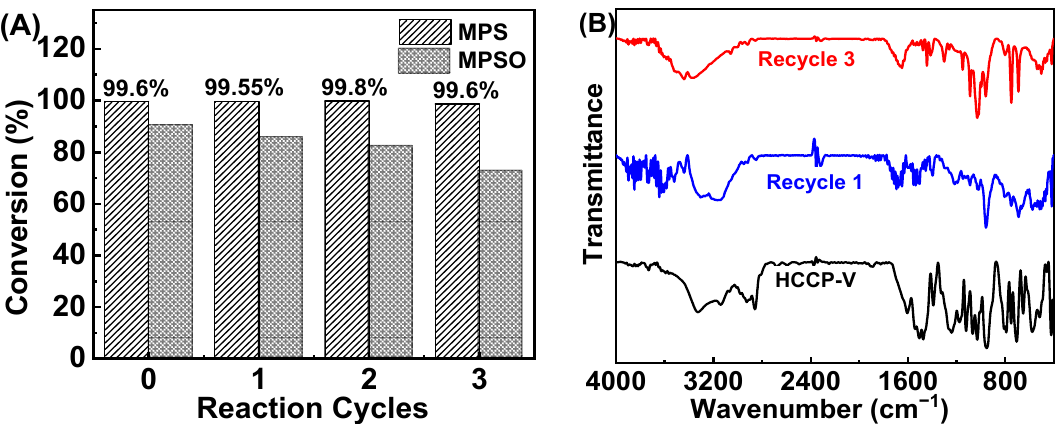
Figure 8. ( A ) The conversion of MPS and MPSO during 4 cycles of reuse of HCCP-V. ( B ) FT-IR spectra for the catalyst HCCP-V during 4 cycles of